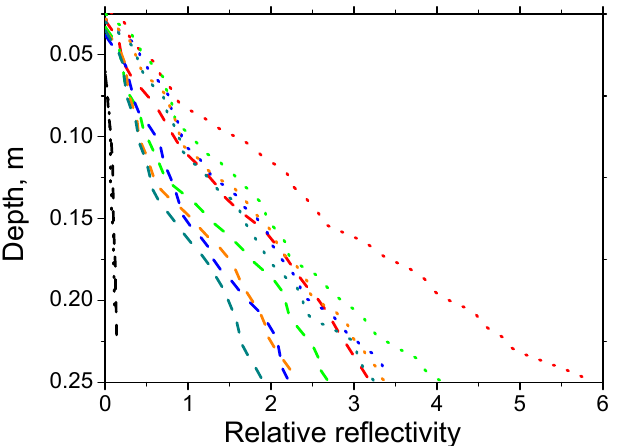
Figure 11. Relative reflectivity of sand f ( h ) for experiment 2 (volume of moistening water 15.1 L, dashed lines) and experiment 3 (volume of moistening water 22.8 L, dotted lines) for different drainage times indicated with lines colors: black—naturally dry sand; red—immediately after moistening; green, blue, brown, and dark blue—after 0.5, 3.5, 24 and 48 h of water drainage.